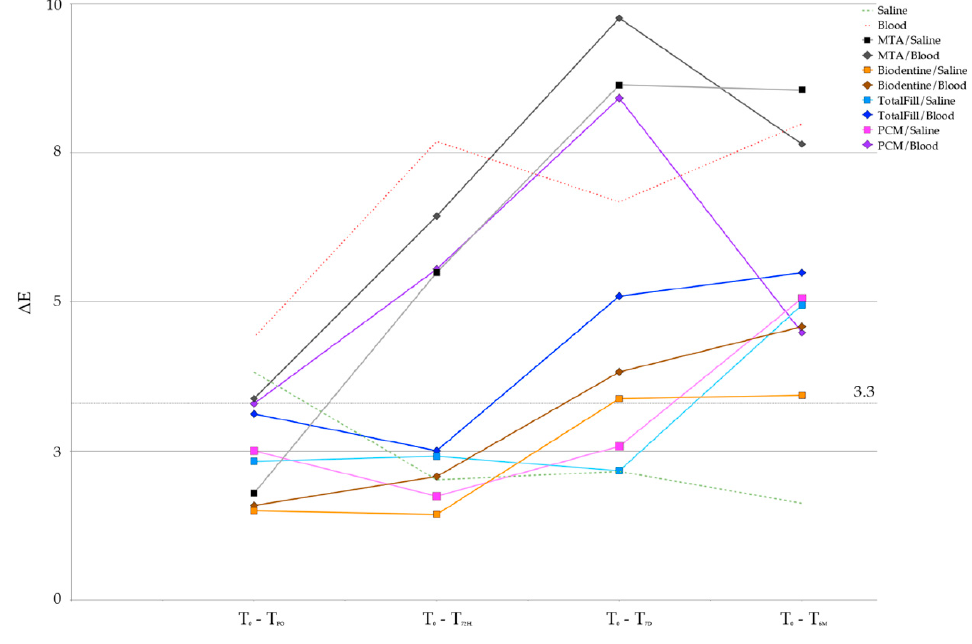
Figure 5. ∆ E of all experimental groups over time.